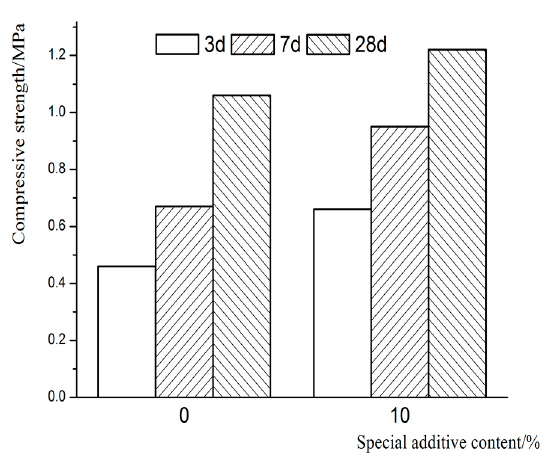
Figure 3. Effect of special additive on bleeding rate of slurry at 8 h.